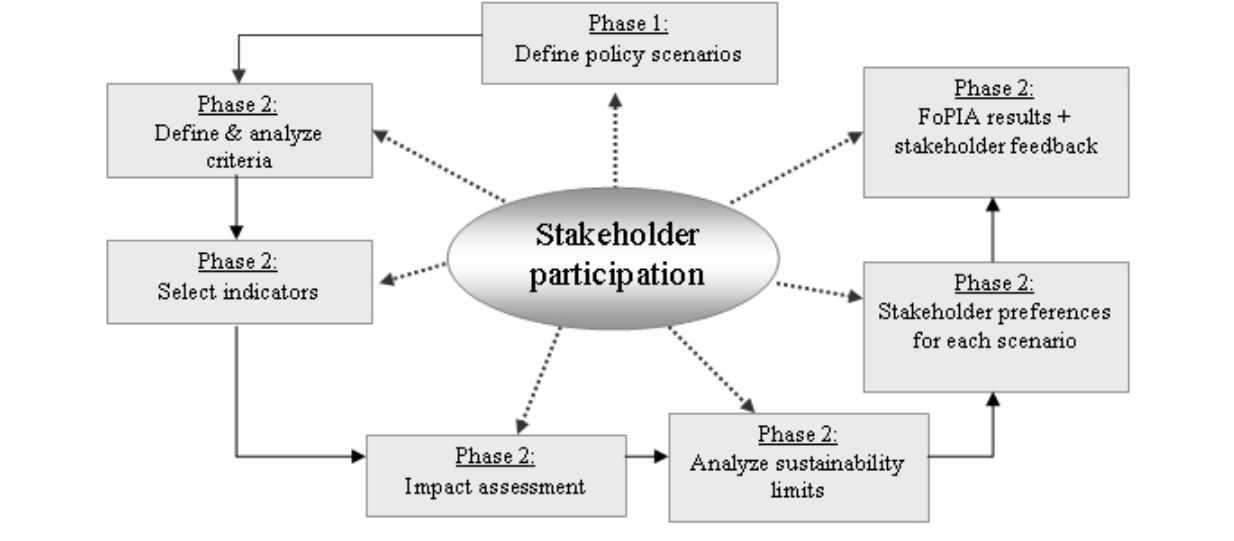
Fig. 1 . Logical structure of the Framework for Participatory Impact Assessment